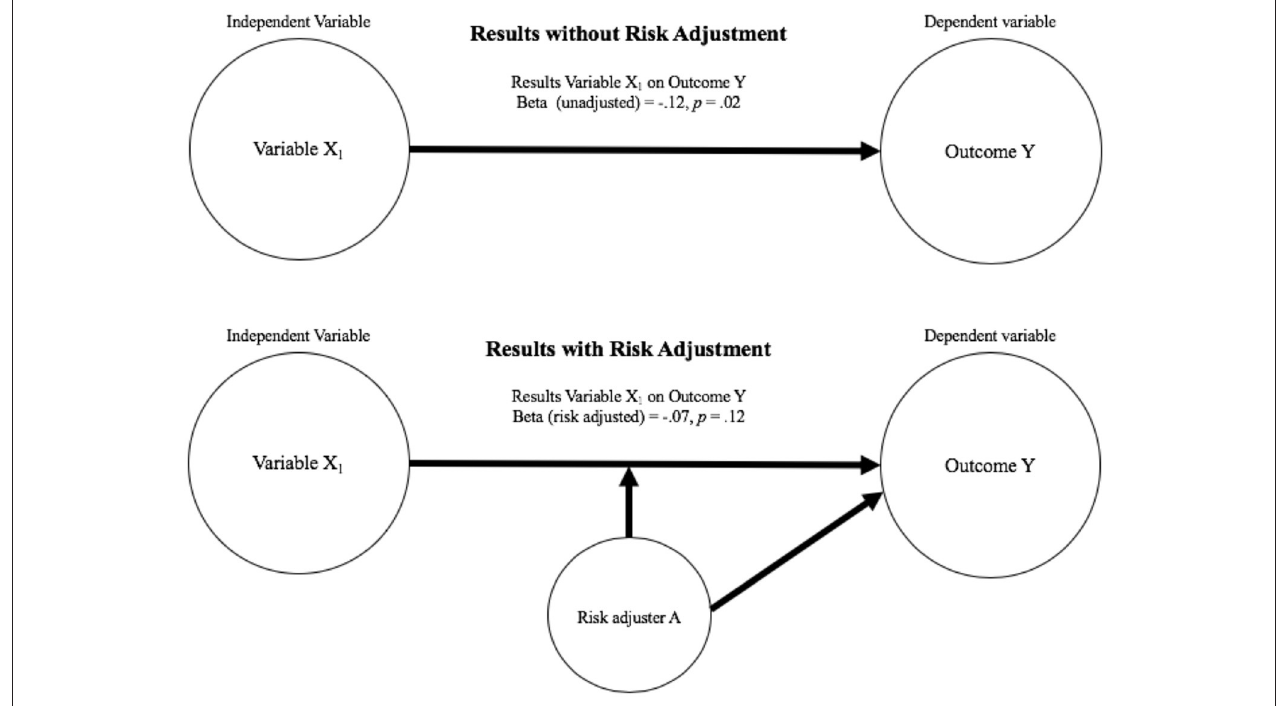
FIGURE 1 | Representation of risk adjusted